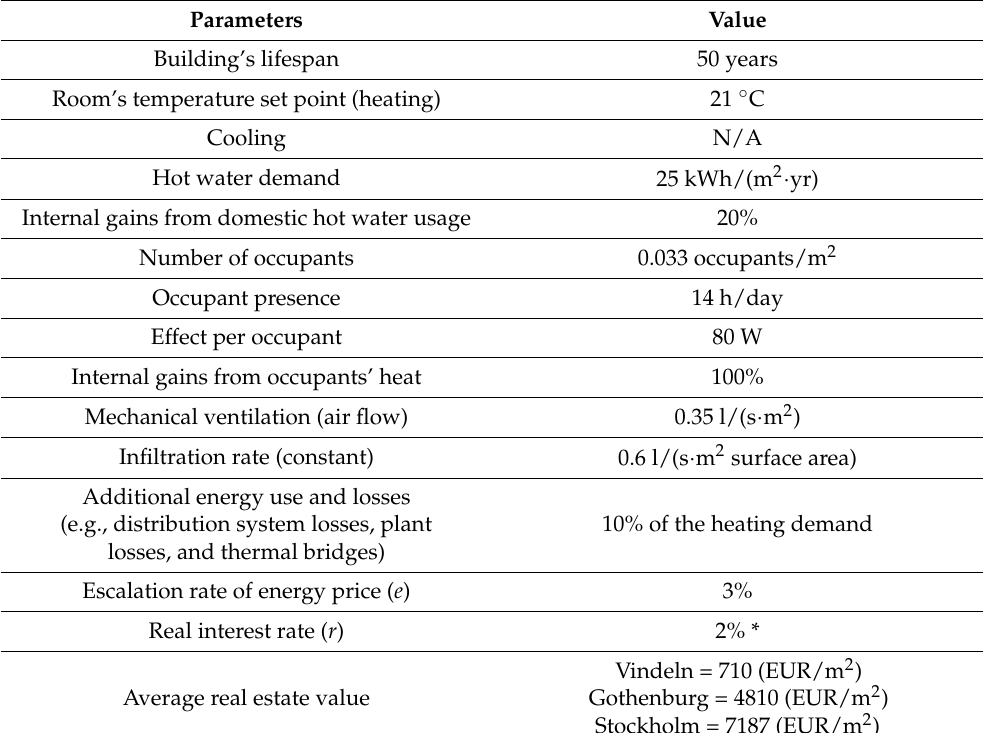
Table 5. Parameters used for optimizing the building’s sustainability